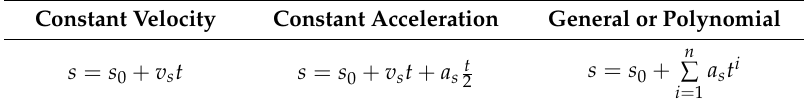
Table 1. Motion models used in this study; more details can be found in Appendix